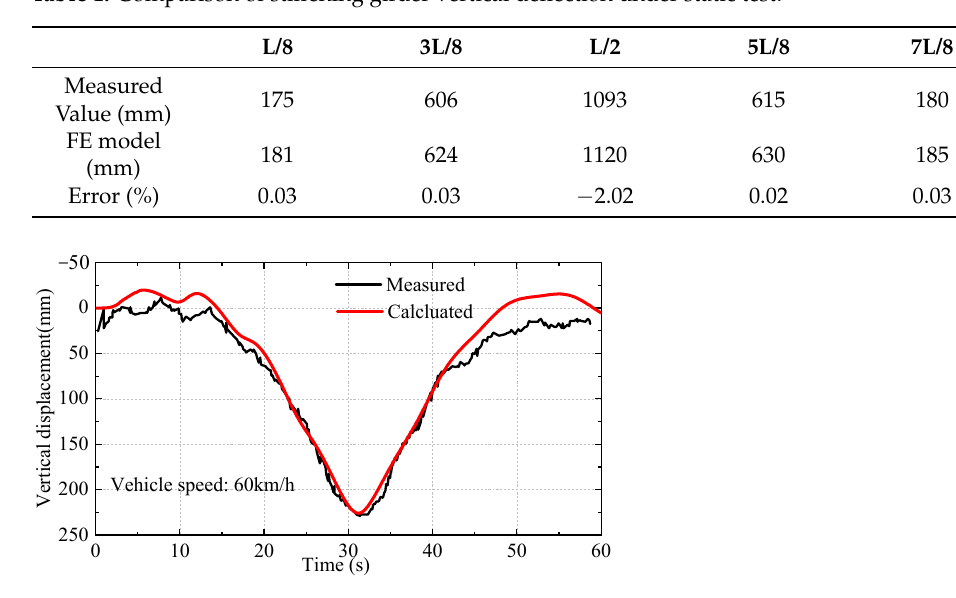
Figure 7. Comparison of midspan dynamic strain under running test.